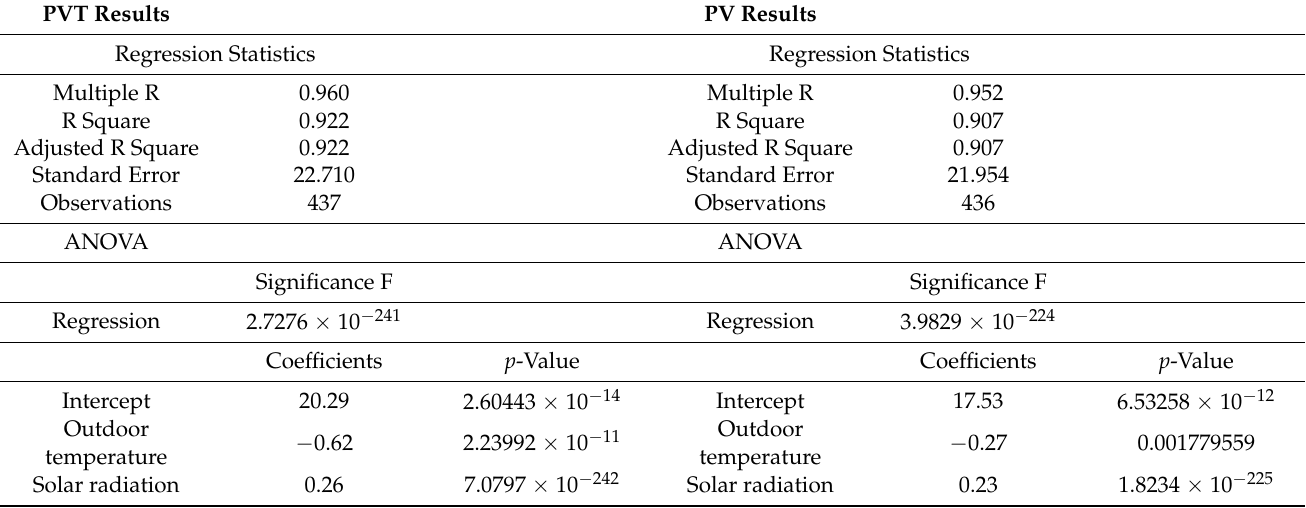
Table 3. Results of regression analysis.